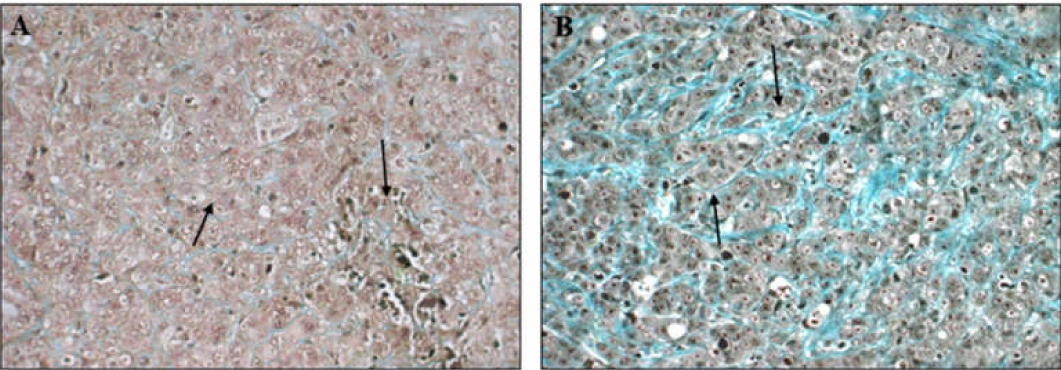
Figure 2. LOXL2 expression promotes the deposition of collagen fibers in tumors: MCF-7 breast cancer derived cells were transfected with an empty expression vector or a vector directing expression of the full length cDNA encoding LOXL2. ( A ) The living parts of tumors derived from MCF-7 cells transfected with empty expression vector which do not suffer from excessive hypoxia contain low concentrations of collagen fibers as revealed by blue Mason’s trichrome staining (arrows). ( B ) In contrast, the living parts of tumors derived from MCF-7 cells expressing recombinant LOXL2 contain much higher concentrations of collagen fibers (arrows) (Pictures taken from reference